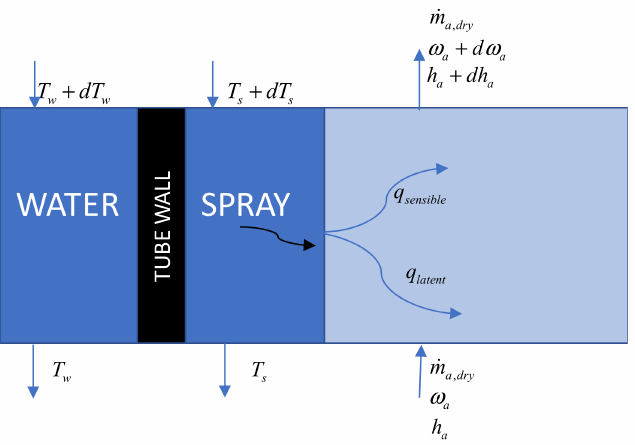
Figure 4. Differential analysis of the cooling